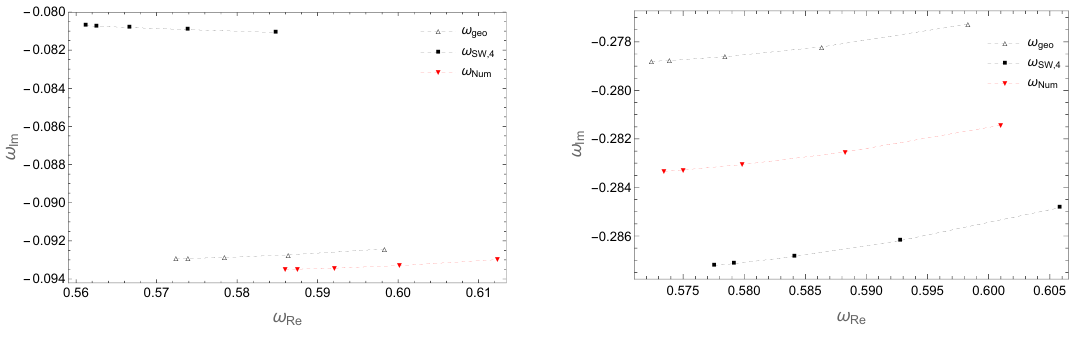
Figure 4 . QNMs of a KN BH for n Num = 1 (left) and n Num = 2 (right), ‘ = m φ = 2 , with = 0 . 5 , M = 1 , Q varies between 0 and 0 . 4 a J